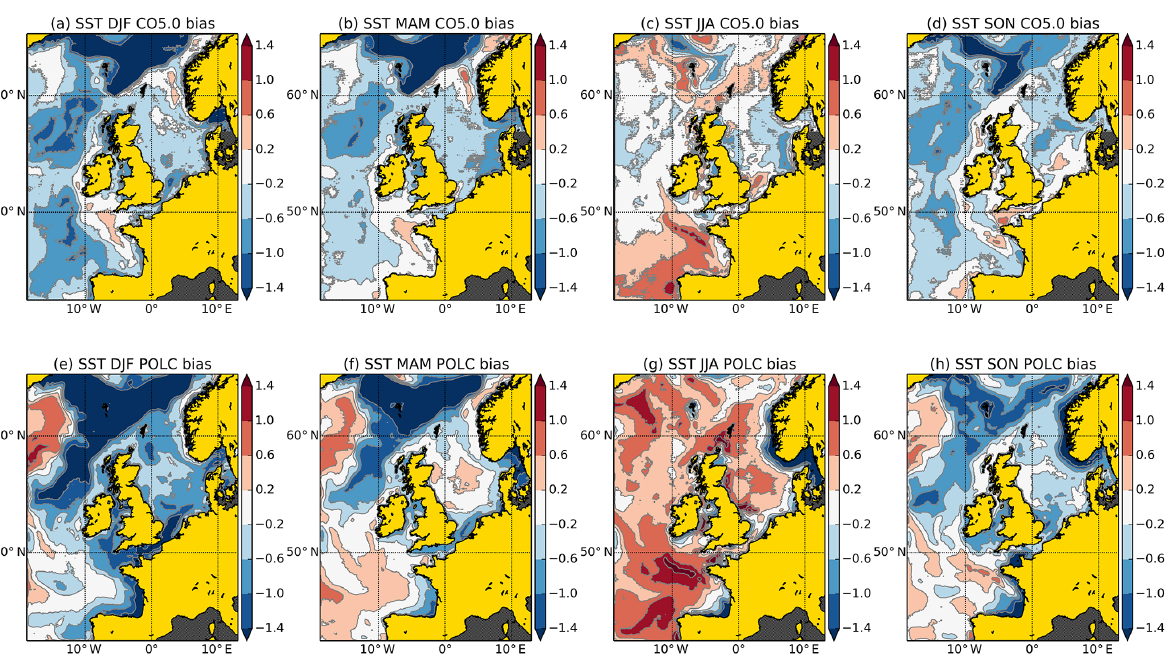
Figure 6. The difference between the mean seasonal model SST and the mean satellite SST for 1985–2004. (a) CO5 December–January– February (DJF) bias, (b) CO5 spring March–April–May (MAM) bias, (c) CO5 summer June–July–August (JJA) bias, (d) CO5 autumn bias September–October–November (SON), (e) POLCOMS (POLC) winter (DJF) bias, (f) POLC spring (MAM) bias, (g) POLC summer (JJA) bias and (h) POLC autumn bias